Question: Write the caption for this figure.
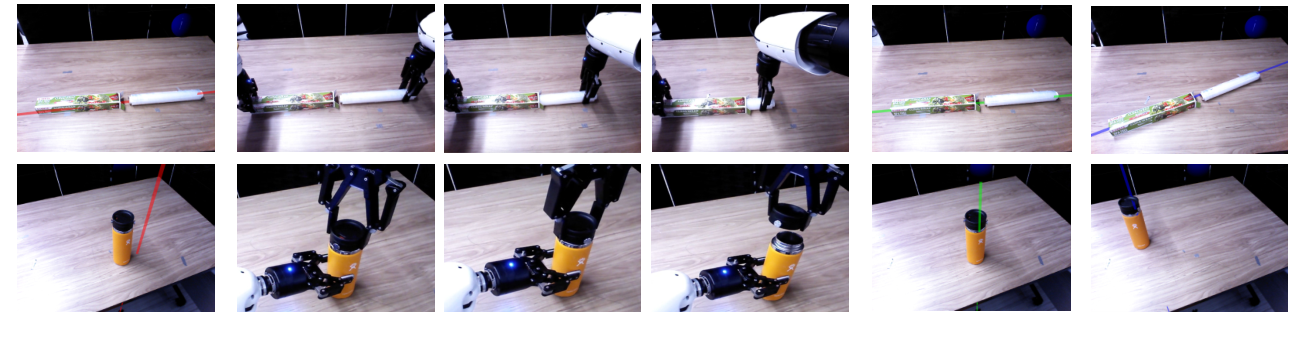
Answer: Generalization to New Objects. The first column shows the axis predicted by M2, the model trained on the corrected screw action for the first object. Columns 2-4 show snapshots from an episode in the fine-tuning stage. Column 5 shows the axis corresponding to the successful trajectory obtained during the aforementioned process. Column 6 shows the predicted axis from the prediction model re-trained on the corrected axis (M3). Thus, SCREWMIMIC can obtain reasonable screw action predictions and fine-tune them to generalize to new objects.